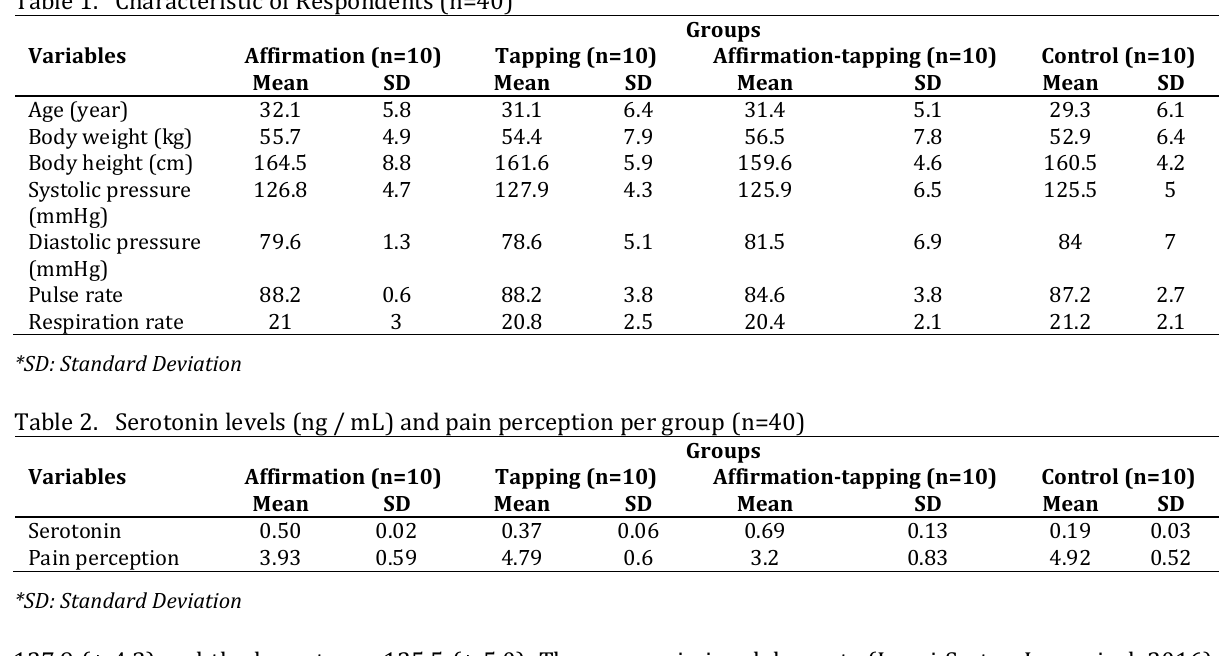
Table 1. Characteristic of Respondents (n=40) Variables